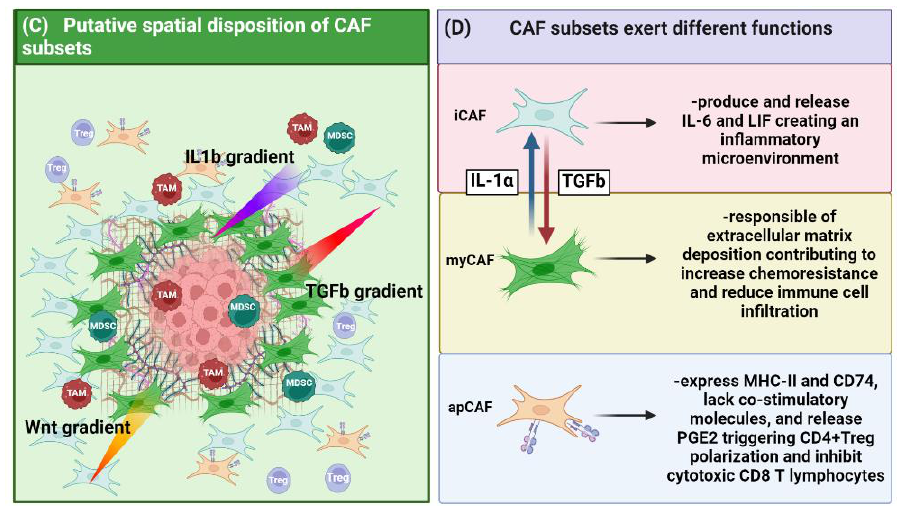
Figure 1. Role of CAF on the TME . ( A ) CAF can differentiate from various cell types such as MSC, endothelial, adipocyte, HSC, pericyte and epithelial cancer cells upon EMT. ( B ) CAF have been characterized under different point of views, ranging from their metabolic impact on the TME, their ability on altering ECM stiffness, as well as by the phenotypical and functional point of view enlisting a series of markers as well as factors they must secrete. ( C ) Different CAF subsets present a differential spatial disposition inside the TME. This effect is strictly dependent on the release by the tumor as well as by the immune cells of cytokines or growth factor, creating a gradient of differentiation triggering either the commitment towards myofibroblast-like CAF (myCAF) (TGF- β gradient), inflammatory CAF (iCAF) (IL-1 β /Wnt gradient,). ( D ) Different CAF subsets exert different